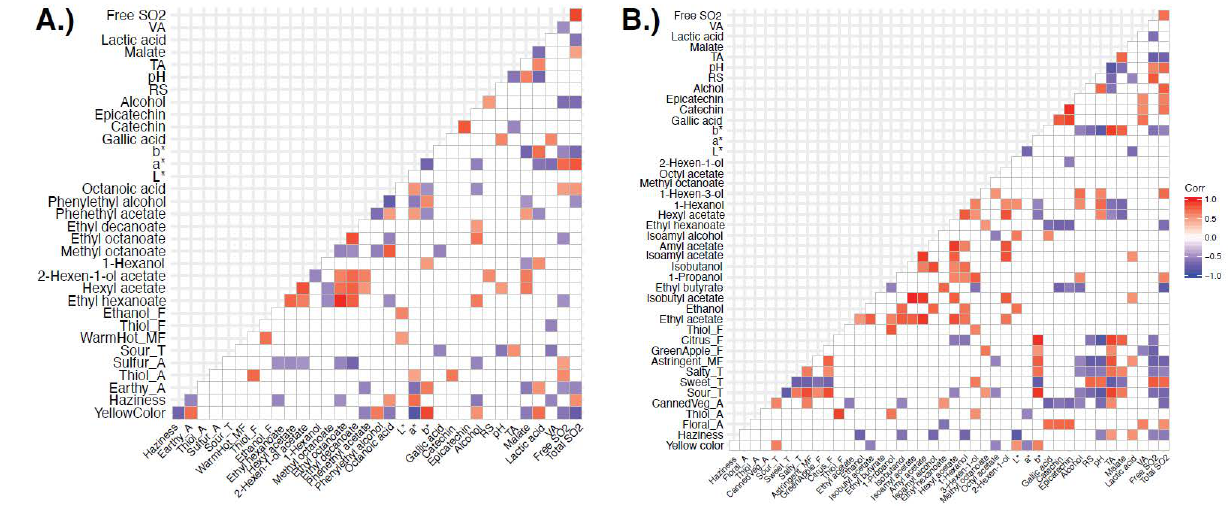
Figure 3. Significant correlation ( p < 0.05) of sensory and chemistry parameters for Year 1 ( A ) and Year 2 ( B ) Grüner V. wines. Positive correlations are shown in red shades while negative correlations are shown in